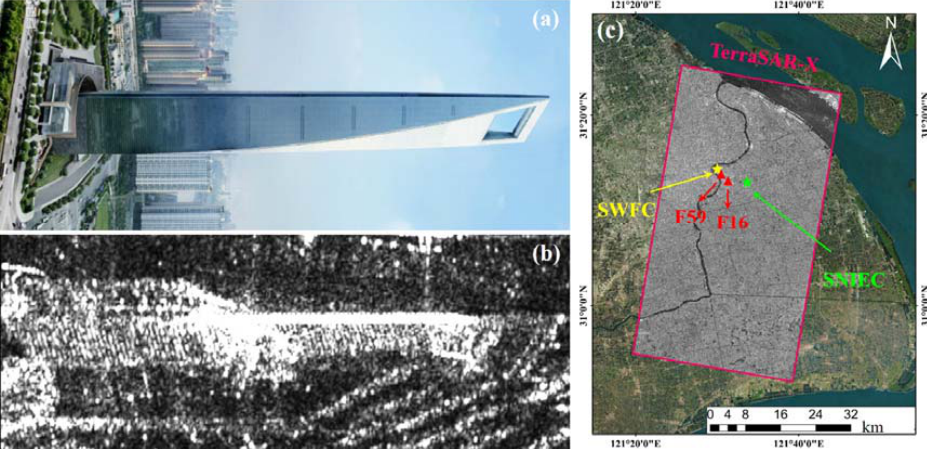
Figure 3. ( a ) The optical picture of the Shanghai World Financial Center (SWFC); ( b ) the SAR amplitude image of the SWFC; and, ( c ) the coverage of TerraSAR ‐ X images in the Google Map (red rectangle), the yellow star indicates the location of the SWFC and the green star represents the SNIEC described in the following, the red triangles are the leveling points. Table 1. Basic information of TerraSAR ‐ X images in Shanghai.